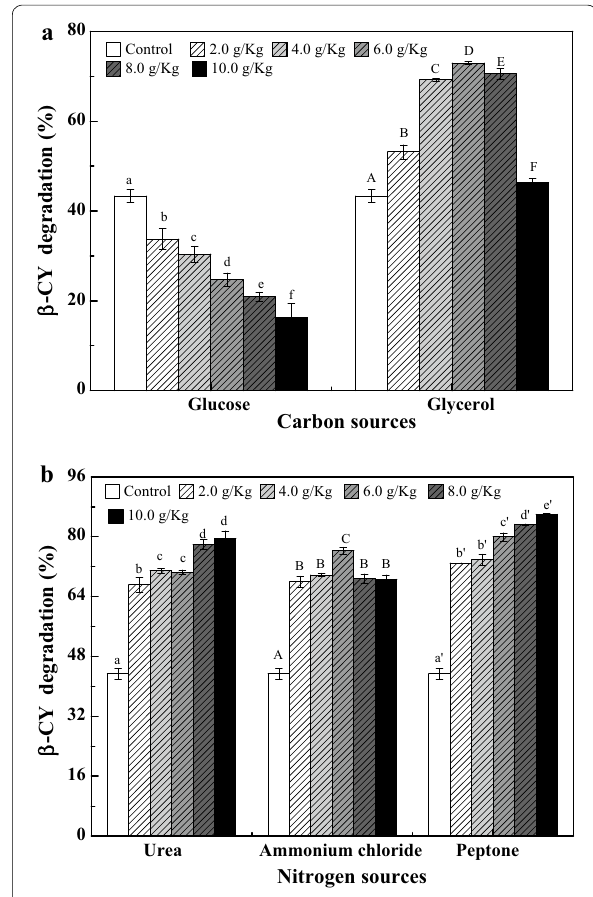
Fig. 5 Effects of the addition of carbon ( a ) and nitrogen sources ( b ) on co-metabolic degradation of β-CY in corn flour by strain B-1. Data are presented as mean standard deviation of three replicates; ± the standard deviations are within 5% of the mean. Different letters indicate significant differences ( p <